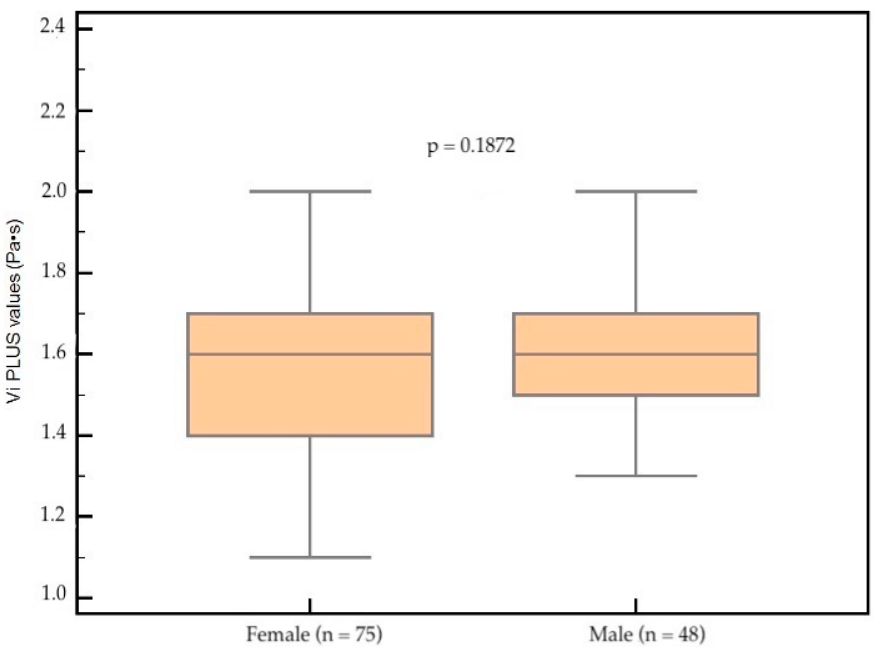
Figure 2. Vi PLUS values according to gender. No significant differences between Vi PLUS mean values were found ( p = 0.1872).